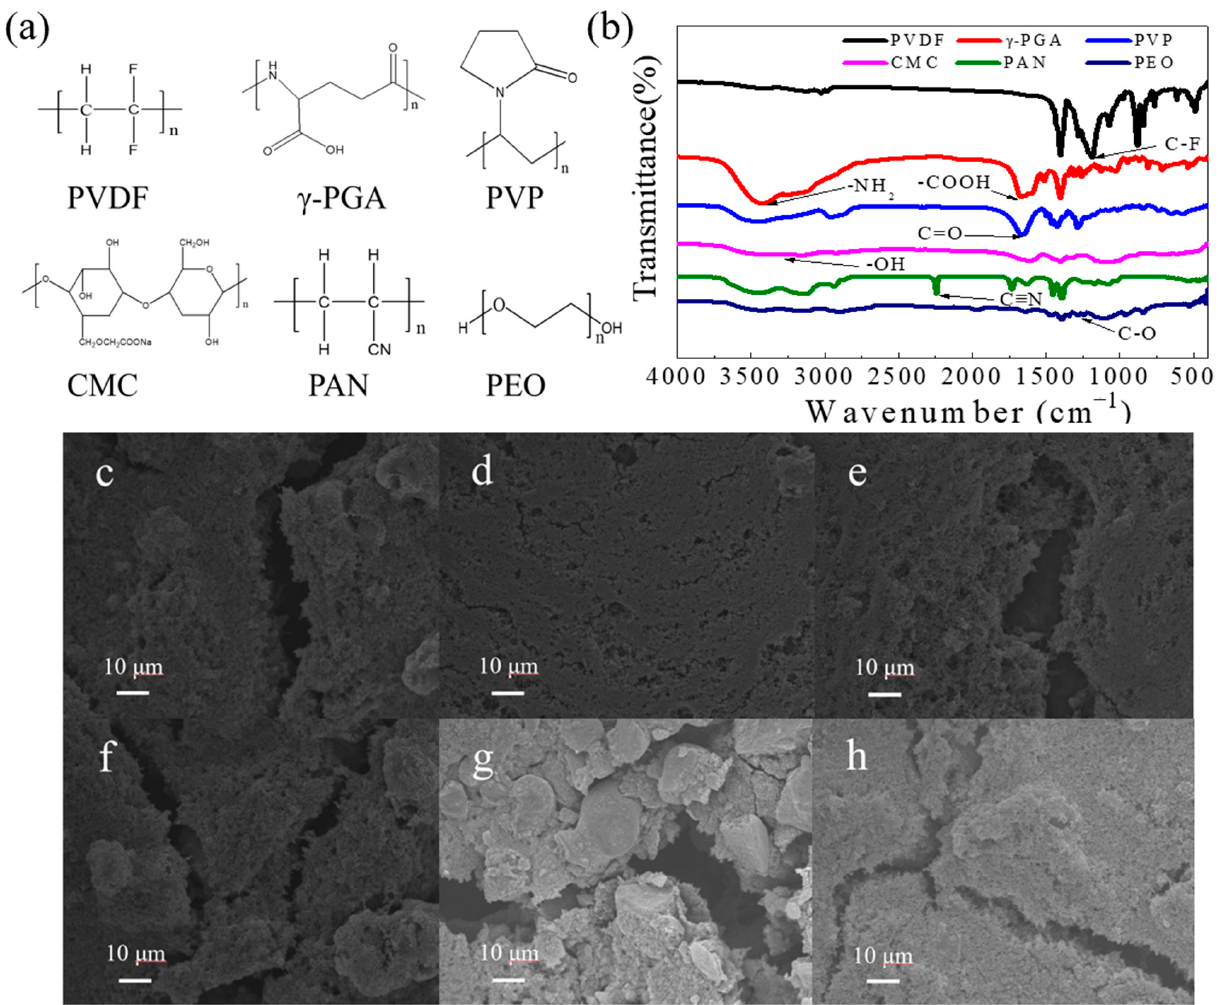
Figure 1. ( a ) Chemical formulae of PVDF, γ -PGA, PVP, CMC, PAN, and PEO binders. ( b ) FTIR spectra of binders. SEM images of electrodes prepared with ( c ) PVDF, ( d ) γ -PGA, ( e ) PVP, ( f ) CMC, ( g ) PAN, ( h ) and PEO binders.